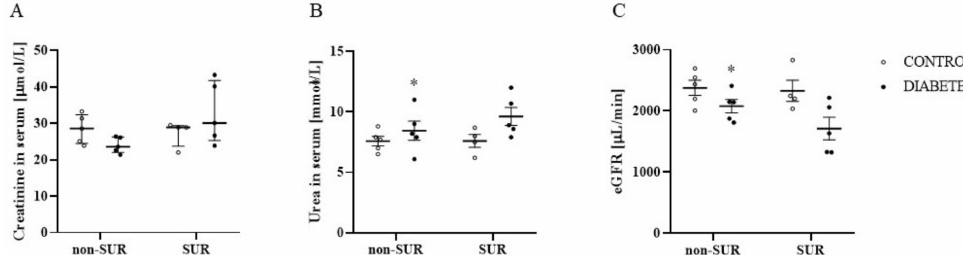
Figure 2. The effects of suramin on creatinine ( A ) and urea ( B ) concentrations in serum and estimated glomerular filtration rate (eGFR) ( C ) in non-diabetic and diabetic rats. Suramin (SUR, 10 mg/kg) or saline (non-SUR) were injected into non-diabetic rats (CONTROL) and streptozotocin-induced diabetic rats (DIABETES) on days 0 and +7 after streptozotocin or citrate buffer injection on day –7. The results obtained on day +14 are presented as single data points with median and 25th–75th percentile (creatinine) or with mean values ± standard error of the mean (urea, eGFR). Statistical significance: * p < 0.05 vs. control non-SUR (two-way